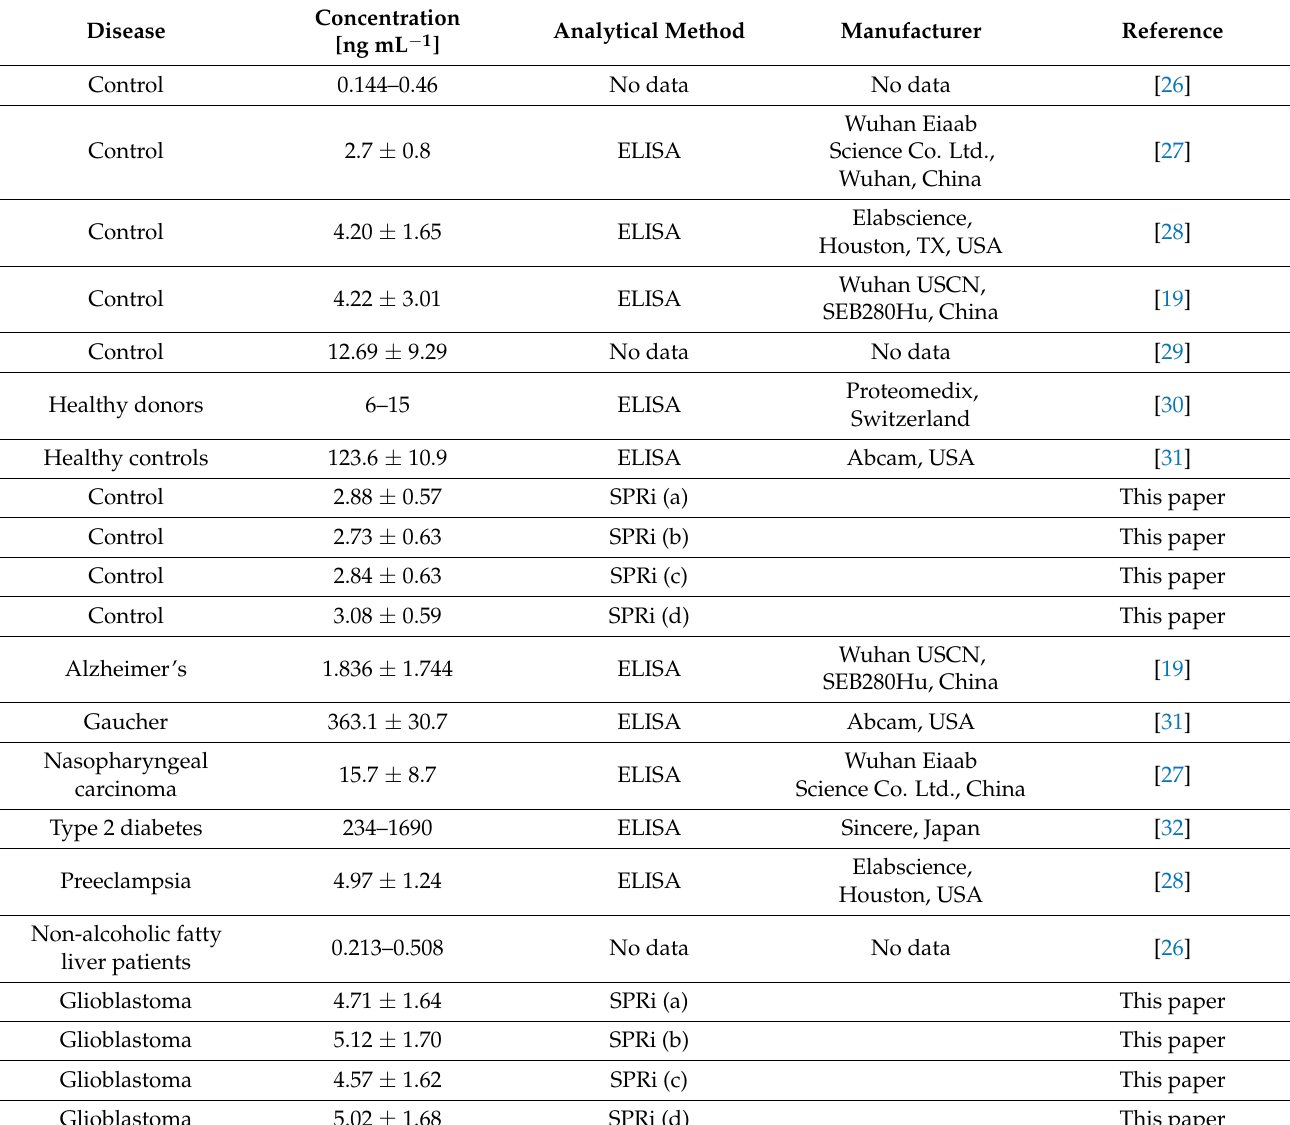
Table 1. Cath D concentration in blood